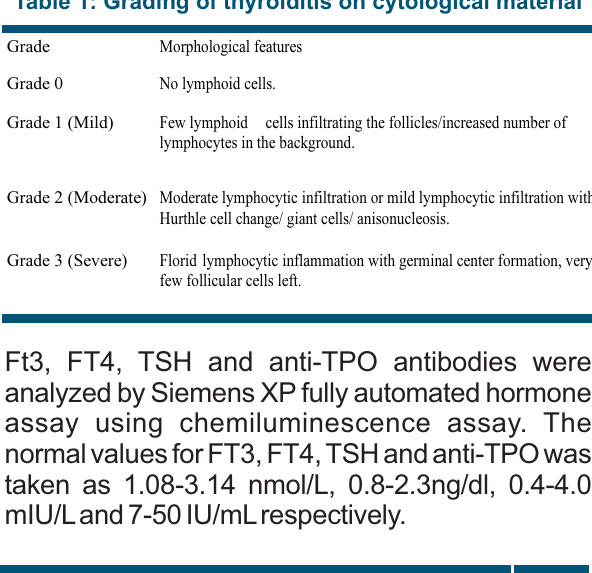
Table 1: Grading of thyroiditis on cytological material